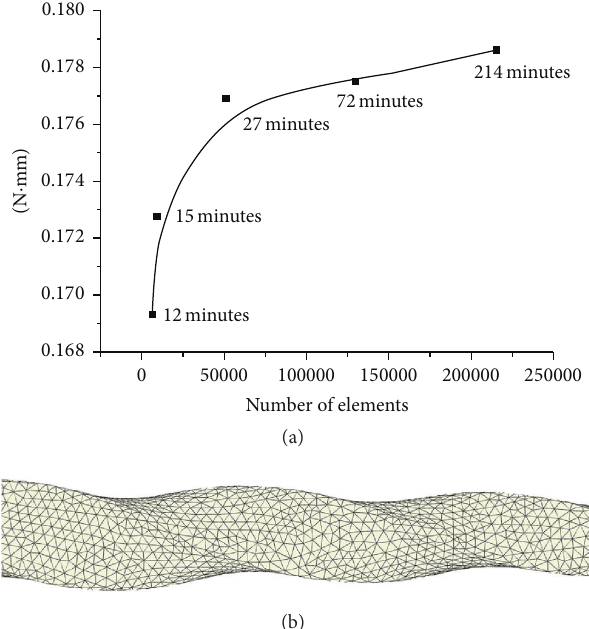
Figure 2: (a) Convergence test: the selected mesh spent 27 minutes to calculate the torque for the chosen condition and (b) a detail of the